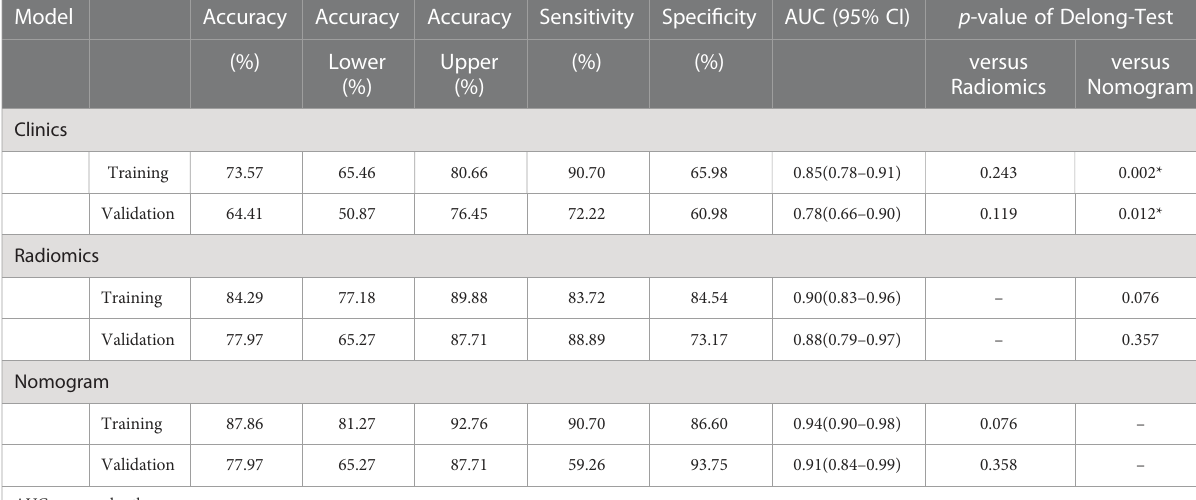
AUC, area under the curve.